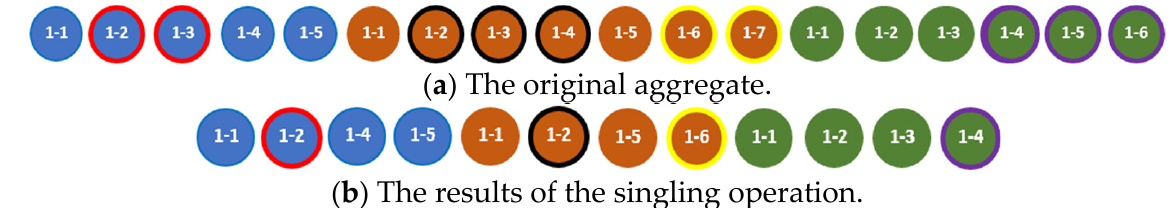
( b ) The results of the singling operation. Figure 20. An example of applying the singling operation. Figure 20. An example of applying the singling operation. The singling operation can be fulfilled according to the algorithm in Listing 11.